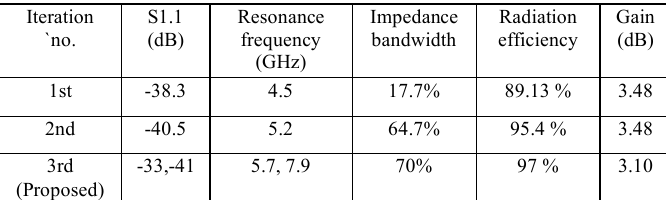
Table 2: Comparison of proposed model based on various iteration numbers.